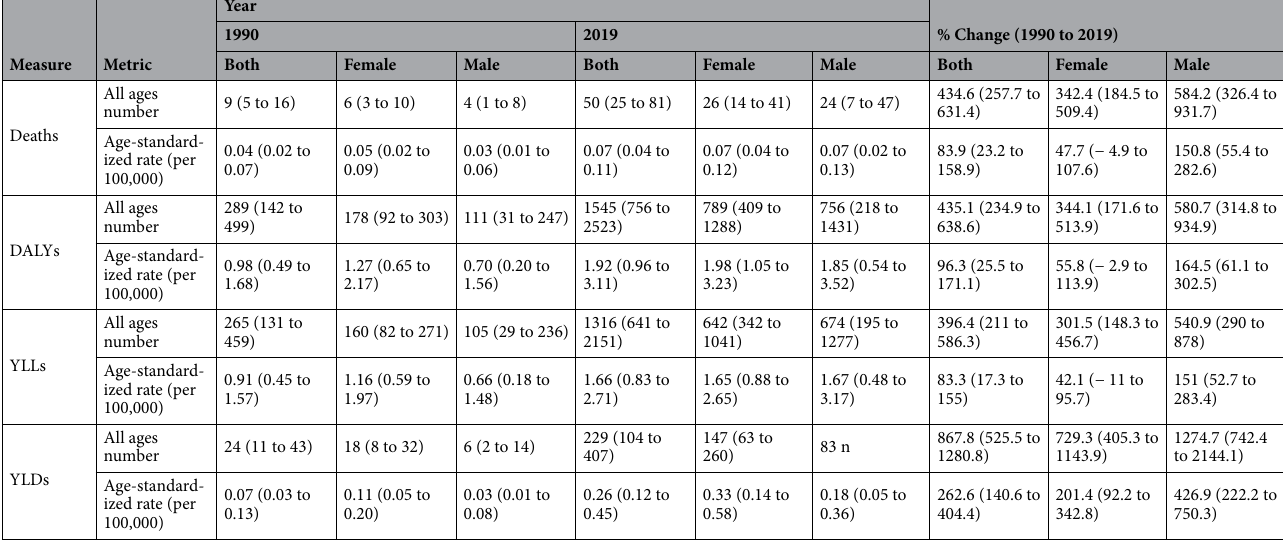
Table 2. Attributed burden measures to high BMI by all ages number and age-standardized rate (per 100,000) by sex in 1990 and 2019 with percent change (%) between 1990 and 2019, Iran. Data in parentheses are